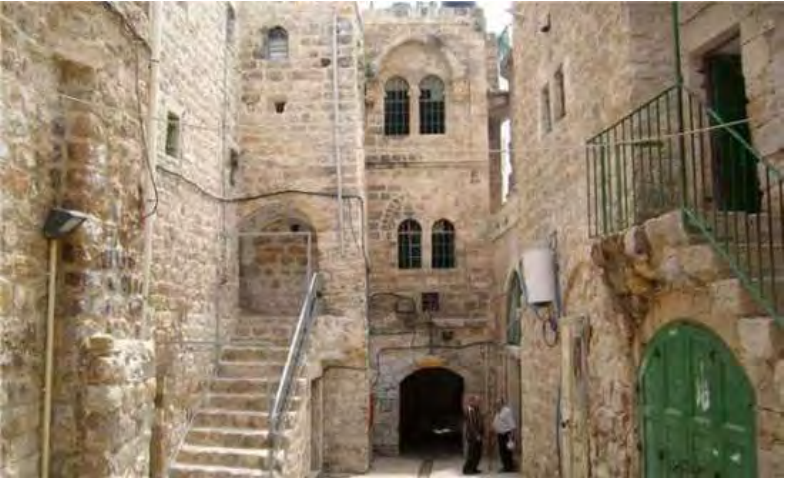
Figure 4. The bad situation of some houses in the old town of